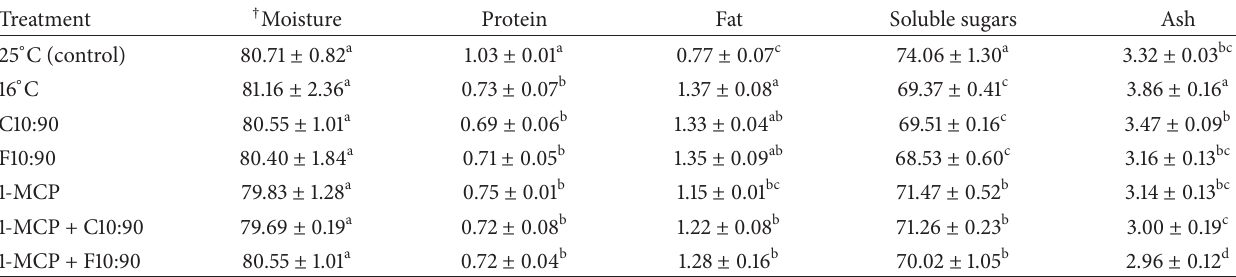
Table 1: Proximate analysis of seedless pulp obtained from soursop stored at 25 ∘ C, 16 ∘ C, fruits with emulsions and stored at 16 ∘ C; fruits treated with 1-MCP and stored at 16 ∘ C; fruits treated with 1-MCP + emulsions and stored at 16 ∘ C (g/100g dry matter of edible portion) ∗